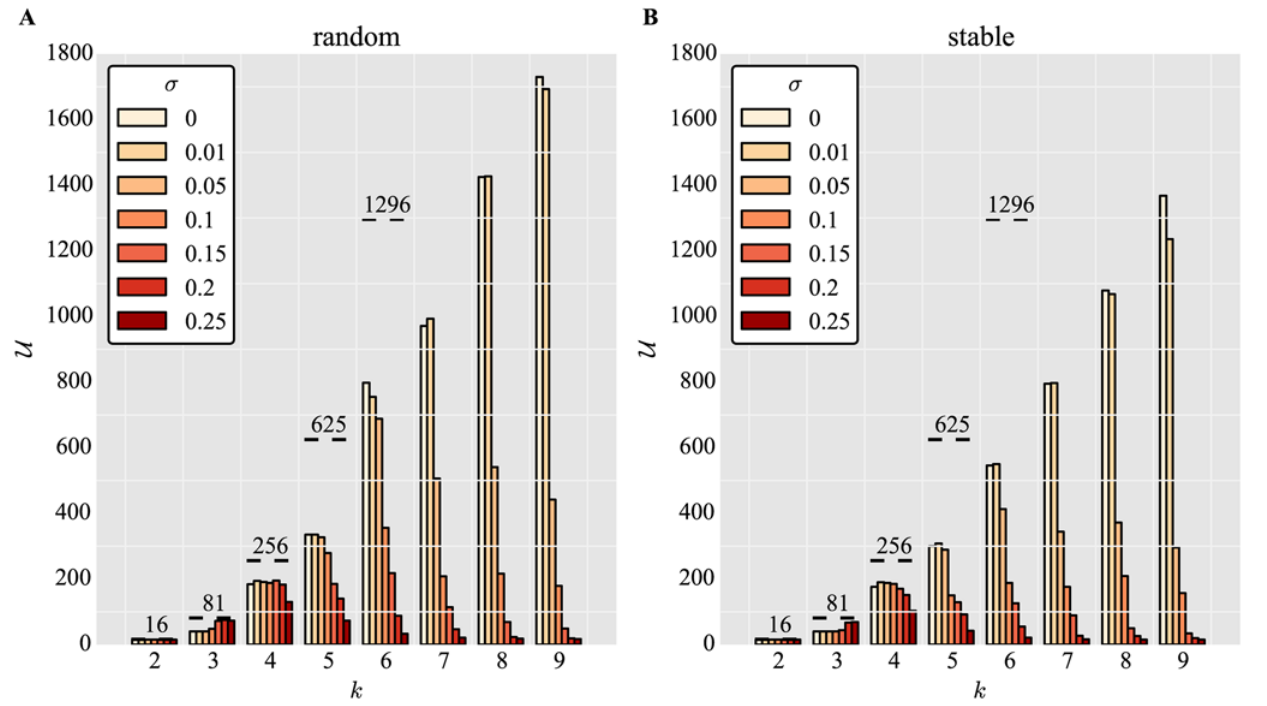
Fig 4. Noise can moderately increase the number of phenotypes accessible by binary networks for intermediate k . Number of unique phenotypes U accessed for different numbers of gene expression states k and varying degrees of noise σ , for (A) random networks and (B) networks pre-selected for stability. Networks are binary, W b , network size N = 4, s off = 0, maximum of T = 100 iterations, and sample size λ = 2.4 × 10 6 . Horizontal dashed lines represent the size of phenotype space: U max = k 4